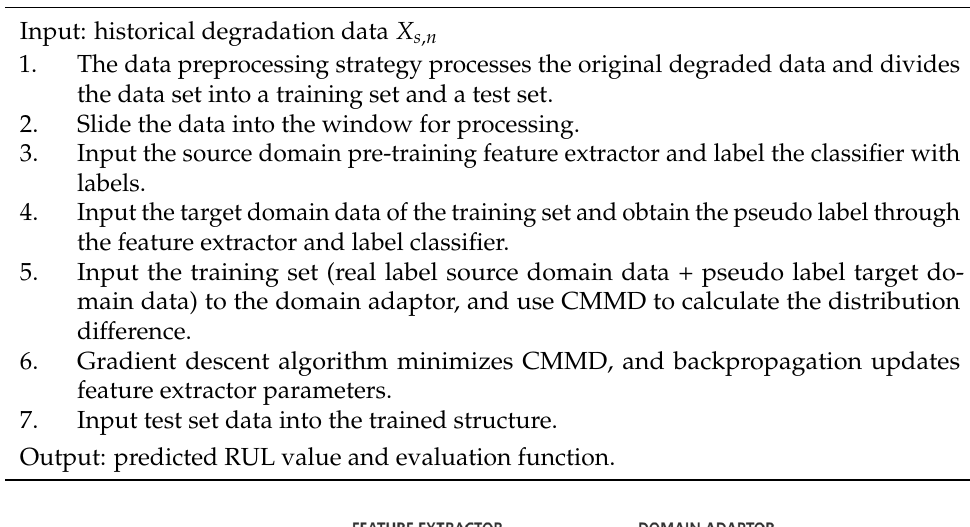
Algorithm 1: Domain adaptation and RUL prediction algorithm.